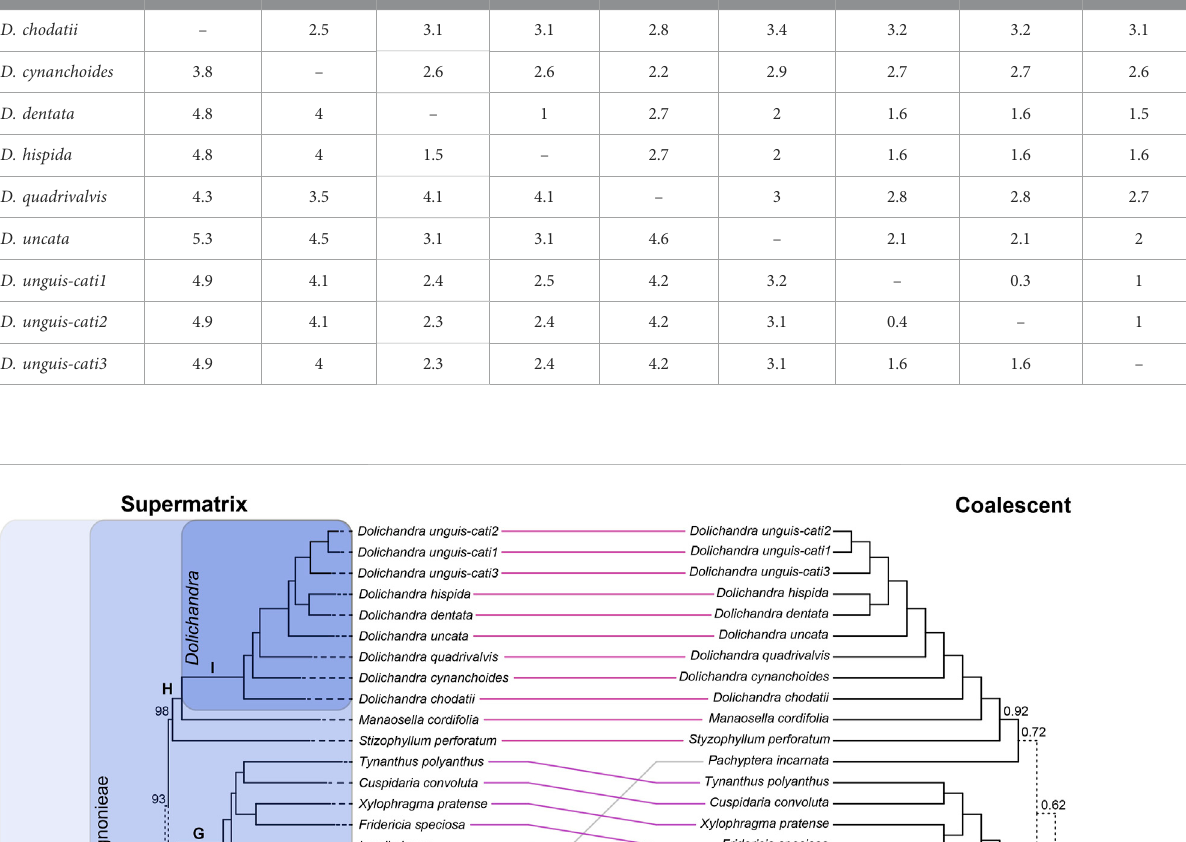
TABLE 3 Comparison of within-genus variation for all species of Dolichandra . Values below the diagonal are pairwise sequence divergences for the Supercontig dataset. Values above the diagonal are pairwise sequence divergences for the Exon-Only dataset. All values are in percentages. D. chod